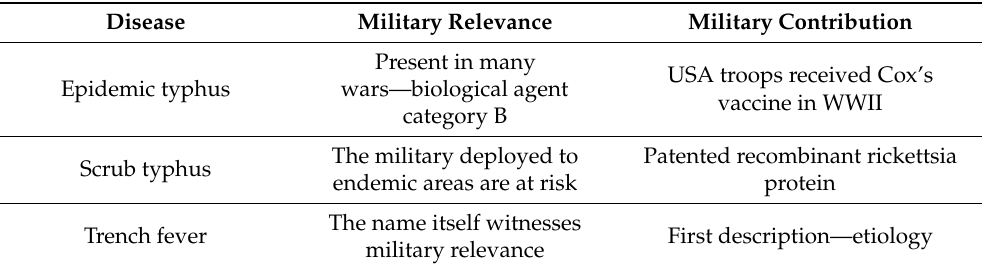
Table 8. Relevance for the military of non-vaccine-preventable infectious diseases and military contribution to their